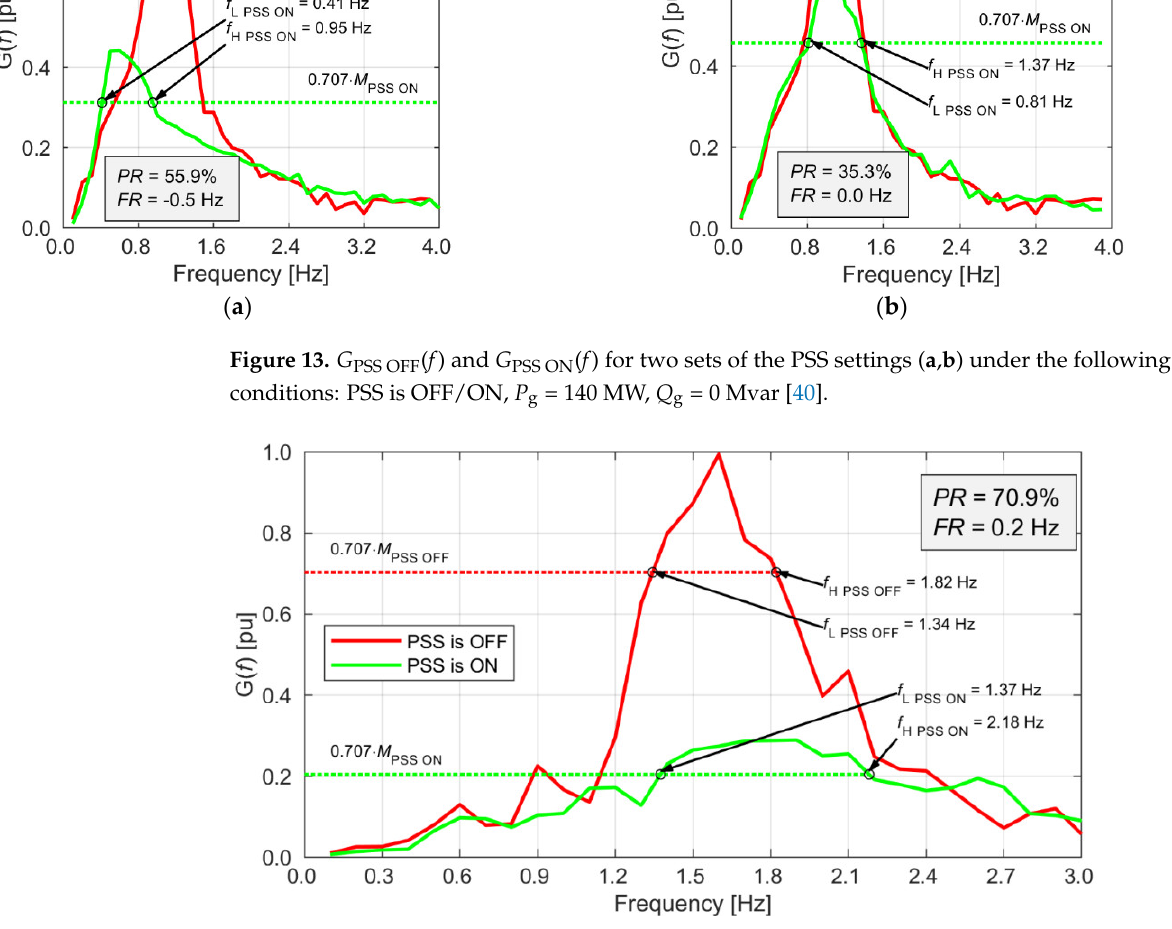
Figure 16. G PSS OFF ( f ) and G PSS ON ( f ), P g = 400 MW, Q g = 4 Mvar [43]. Figure 17. G PSS OFF ( f ) and G PSS ON ( f ), P g = 208 MW, Q g = 0 Mvar [44].